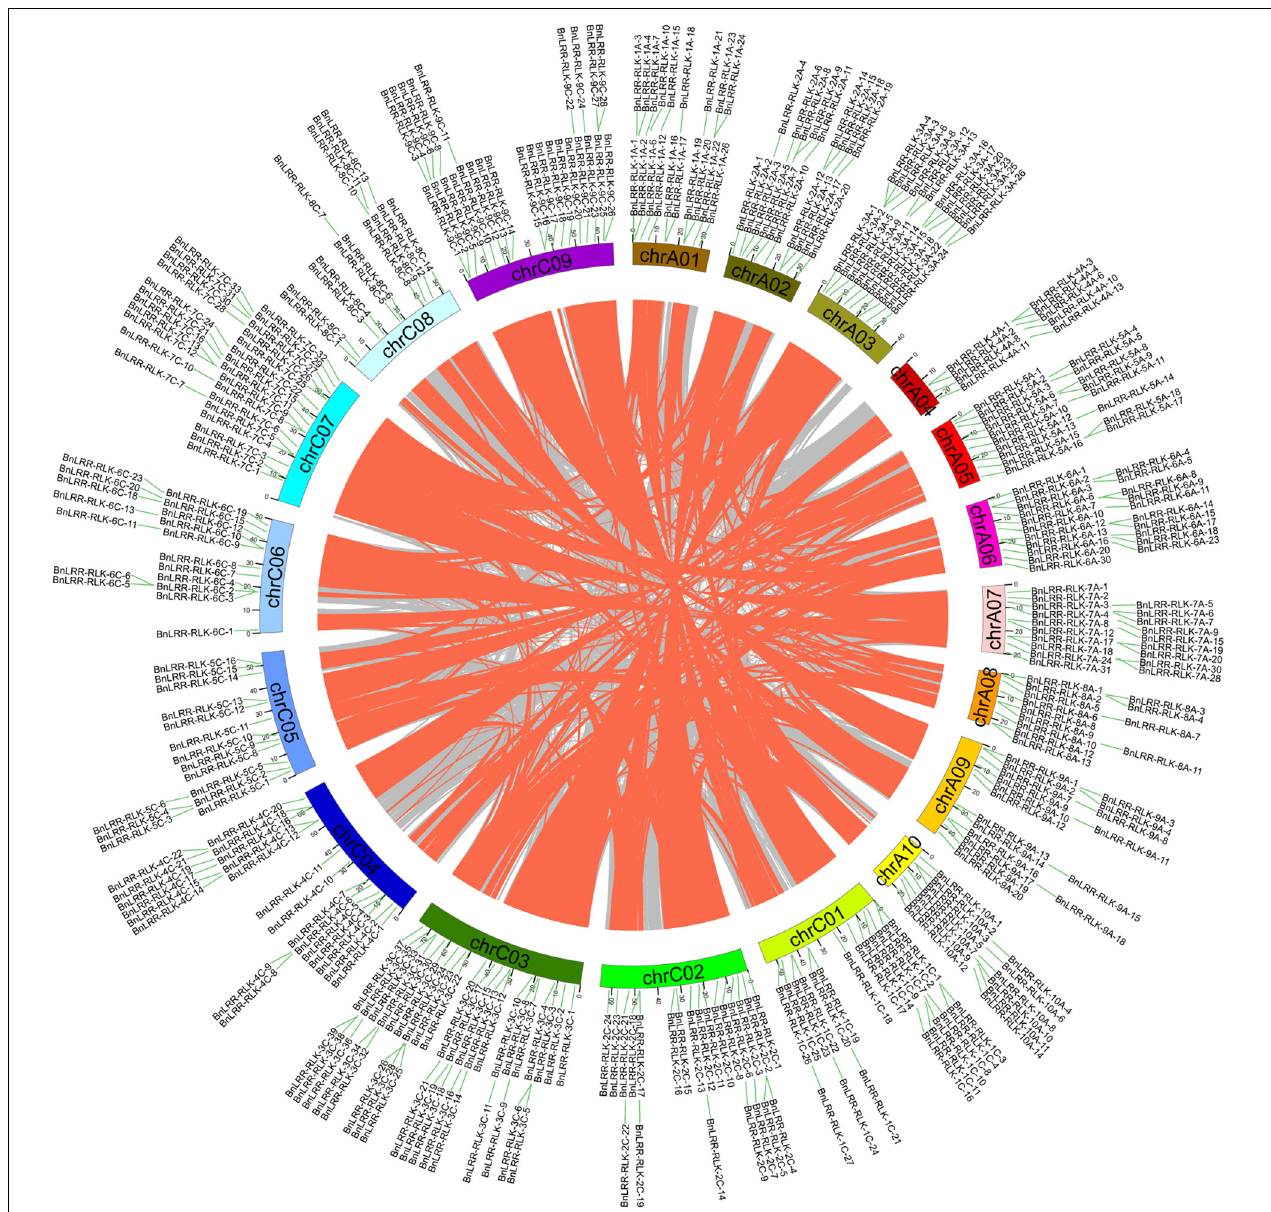
FIGURE 2 | The chromosome locations associated with BnLRR-RLKs segmental duplication in B. napus . The gray and orange lines represent all synteny blocks in B. napus Cultivar ZS11 genome and segmental duplicate gene pairs, respectively. Different chromosomes are indicated by different